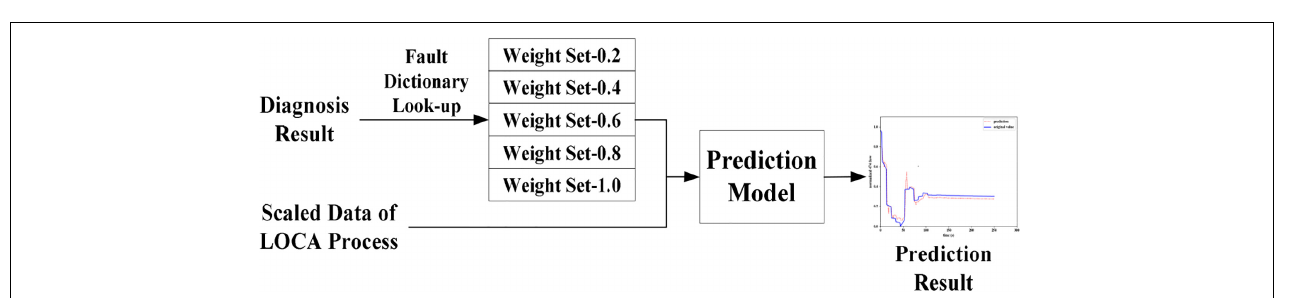
FIGURE 3 | Using fault dictionary for Post-LOCA prediction.